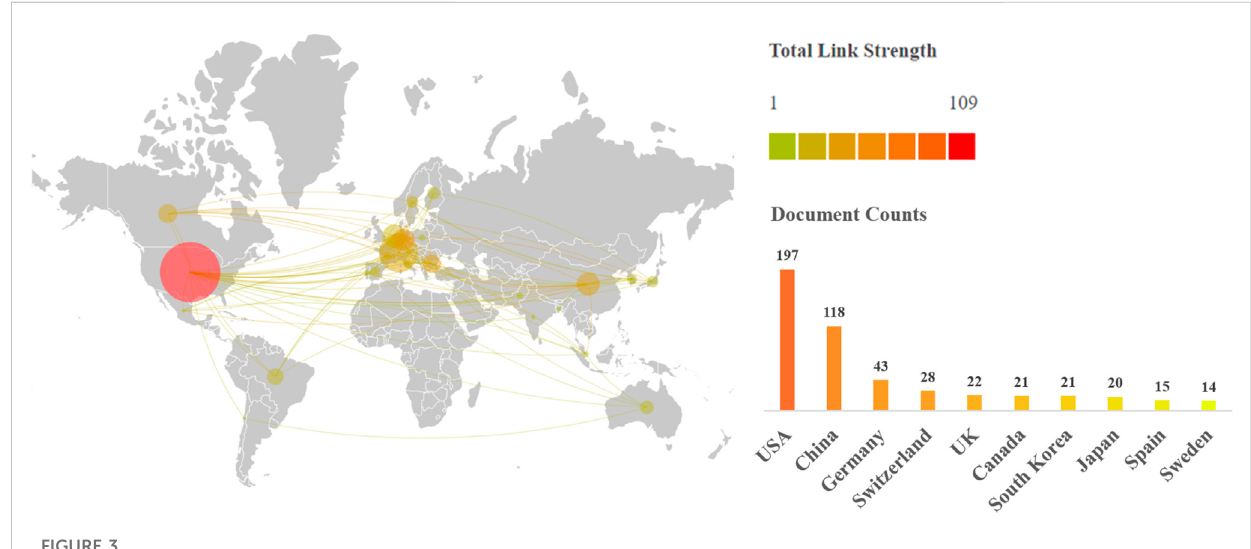
Country collaboration network and top 10 countries in UPR mt .